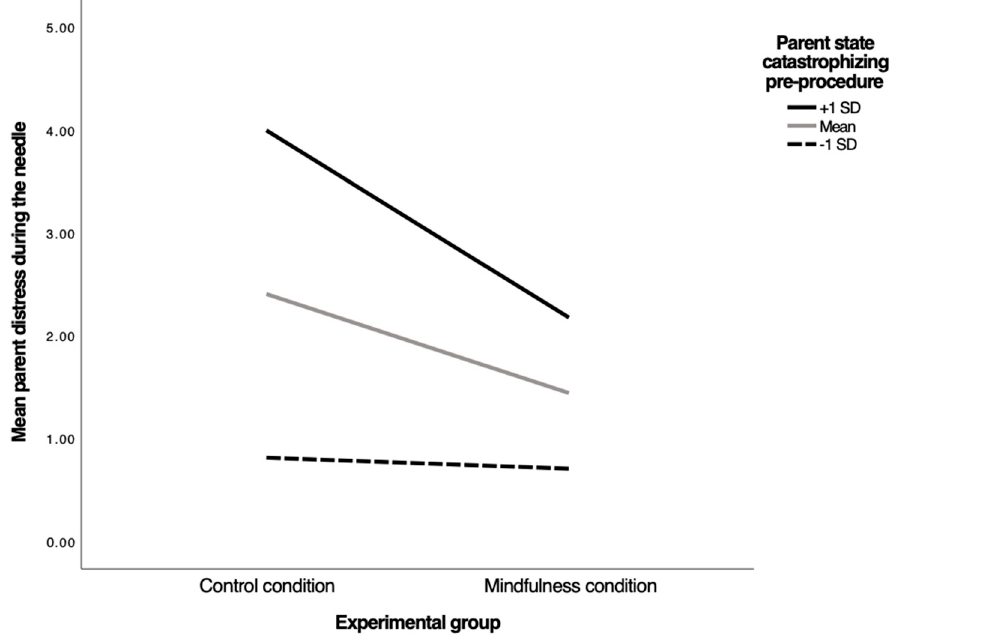
Figure 2. A visual representation of the conditional effects of the experimental group on parent distress during the venipuncture, among those with low ( − 1 SD), moderate (mean), and high (+1 SD) levels of parent state catastrophizing, pre-venipuncture.